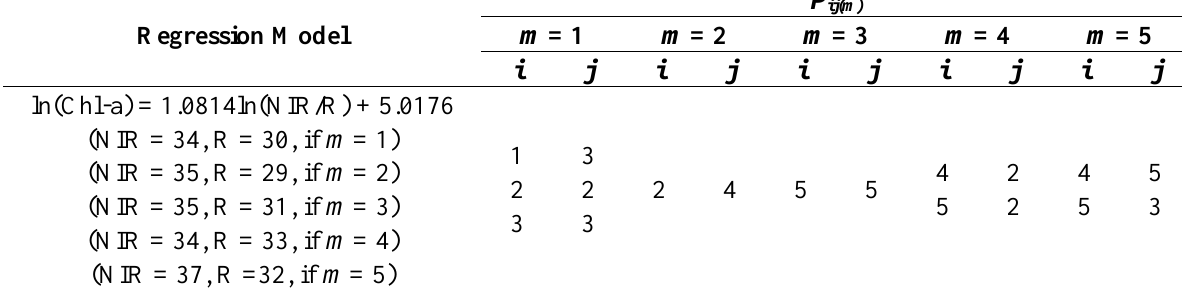
Table 7. Elements P ij ( m ) corresponding to optimal regression models obtained by the MPP method. Regression